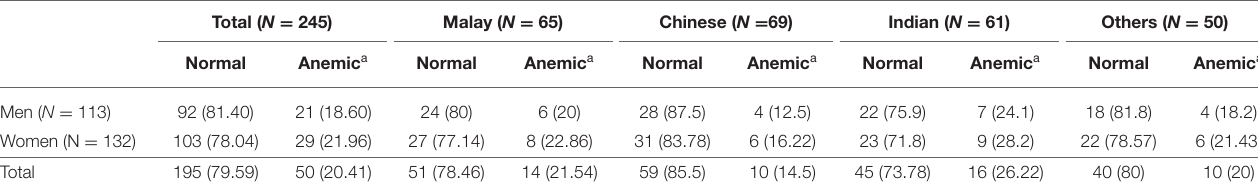
TABLE 7 | Distribution of respondents according to their gender, ethnicity, and prevalence of anemia. Total ( N = 245) Malay ( N = 65) Chinese ( N = 69) Normal Anemic a Normal Anemic a Normal Anemic a Normal Anemic a Normal Anemic